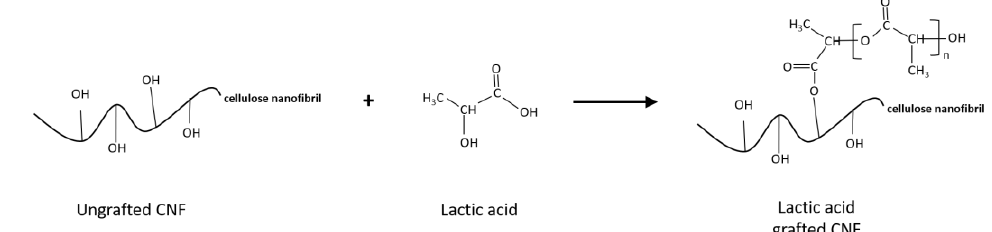
Figure 2. FTIR spectra of ungrafted CNF, LA-grafted CNF, and sonicated LA.